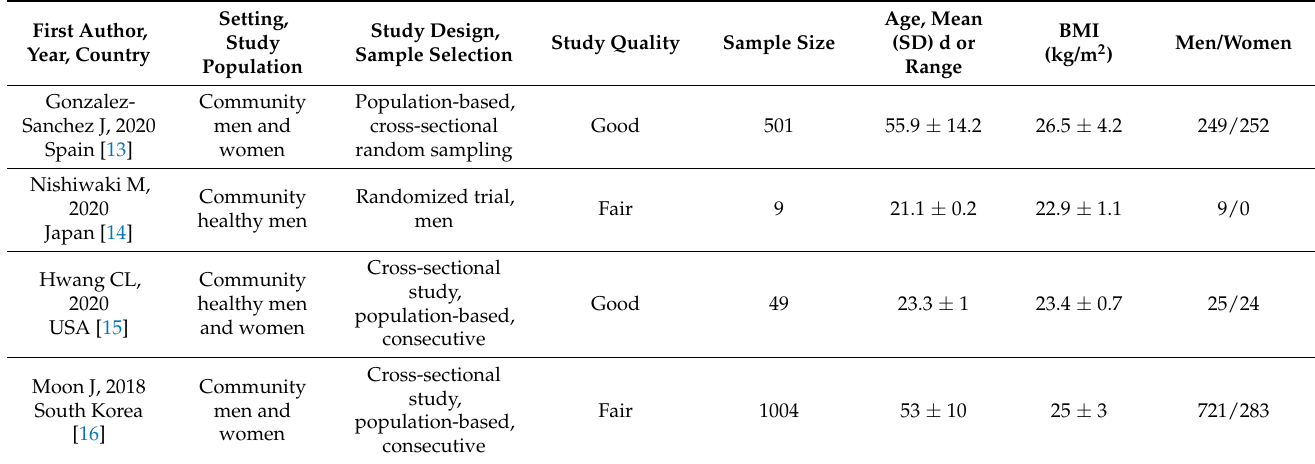
Table 2. Summary table of primary studies included in the systemic review.